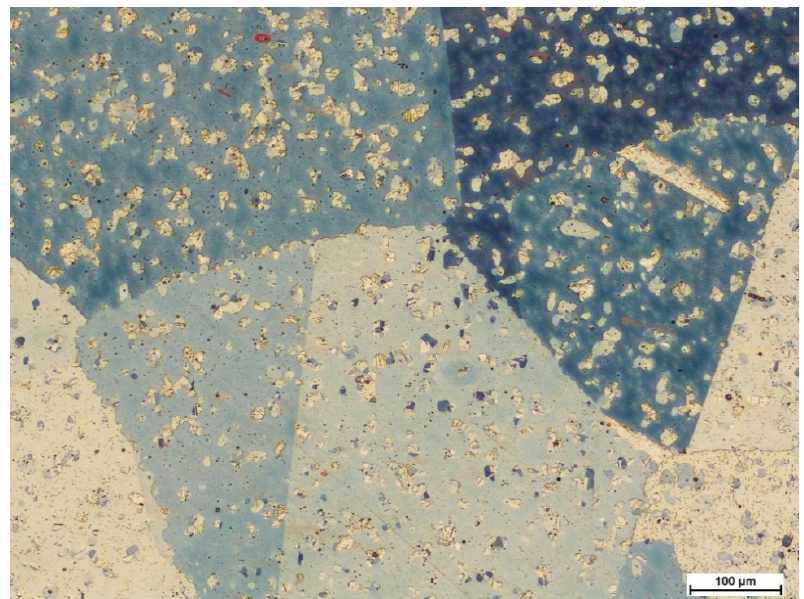
Figure 12. Microstructure of X120Mn12 steel after re-austenitisation at 900 °C. Sample previously isothermally annealed at 510 °C and cooled with furnace. Significant disappearance of the amount of carbides and fine pearlite colonies from the previous state is visible. Numerous new austenite grains of less than 20 μ m in size are visible. Etched state. LM.